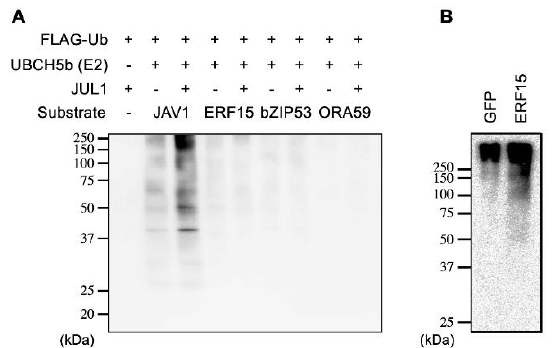
Figure 4. In vitro JUL1 ubiquitination activity on JAV1 and JiTFs (JiTF3 [ERF15], JiTF5 [bZIP5] and JiTF7 [ORA59]) as substrates. ( A ) Biotinylated JiTFs and JAV1 proteins were incubated with FLAG-tagged ubiquitin (FLAG-Ub), UBCH5b (E2) and AGIA-tagged JUL1. ( B ) Likewise, biotinylated JAV1 proteins were incubated with FLAG-Ub, UBCH5b, and AGIA-tagged JUL1 in the presence of AGIA-tagged GFP or ERF15. The incubated reaction mixtures were immunoprecipitated using streptavidin-linked magnetic beads, subjected to SDS-PAGE, and probed with an anti-FLAG-HRP (FLAG-Ub) antibody. The smeared signals indicate possible ubiquitinated substrate proteins.